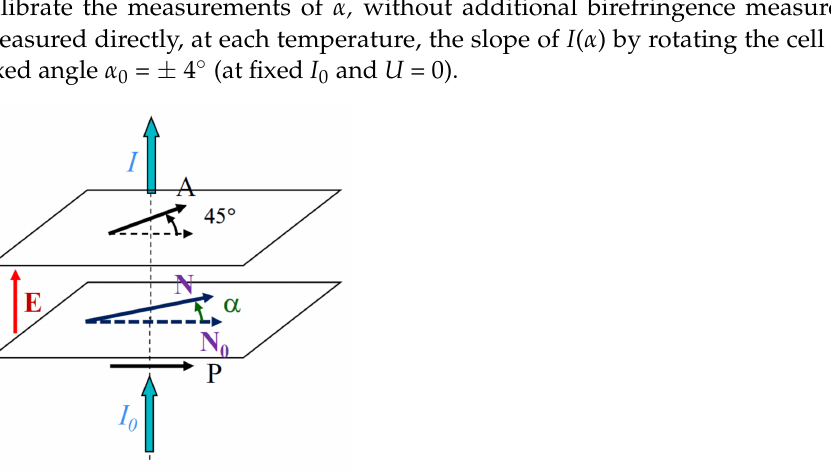
Figure 4. The optical geometry used for the ECE NTB